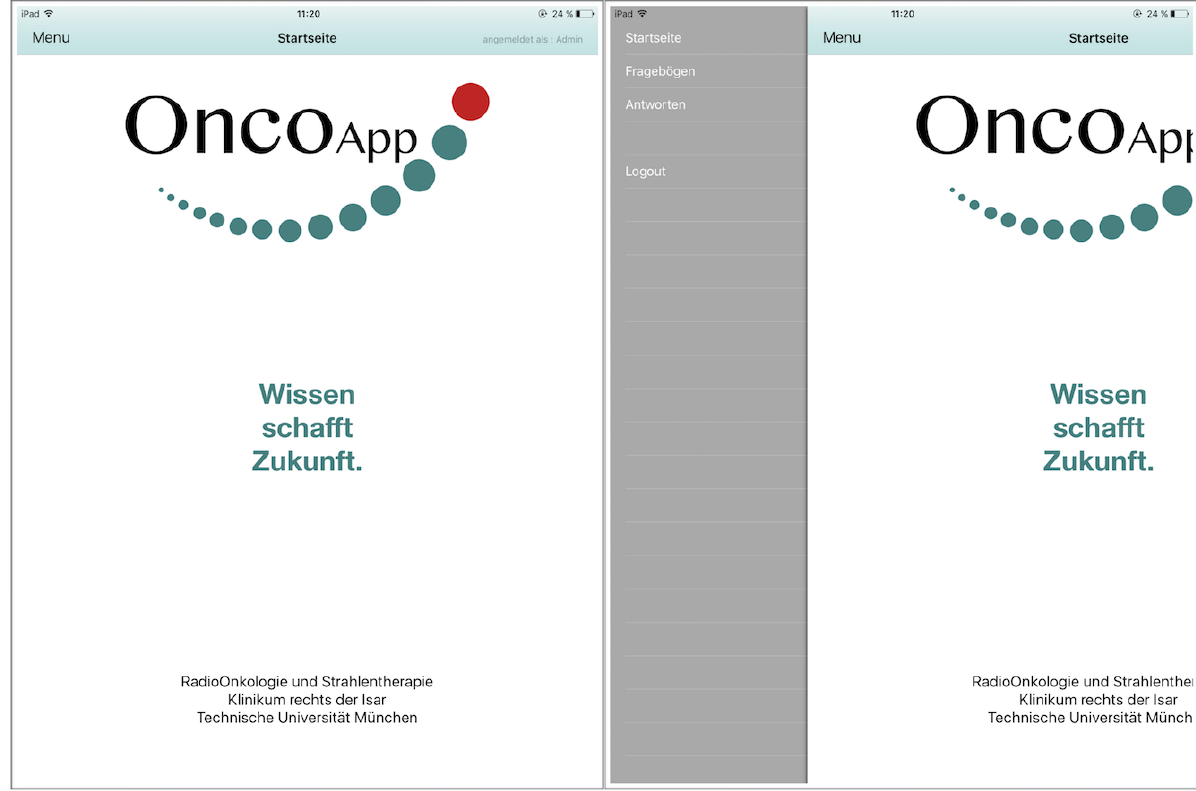
Figure 2. Screenshot of the start page (left) and slide bar of the menu (right). Administrator view is displayed.